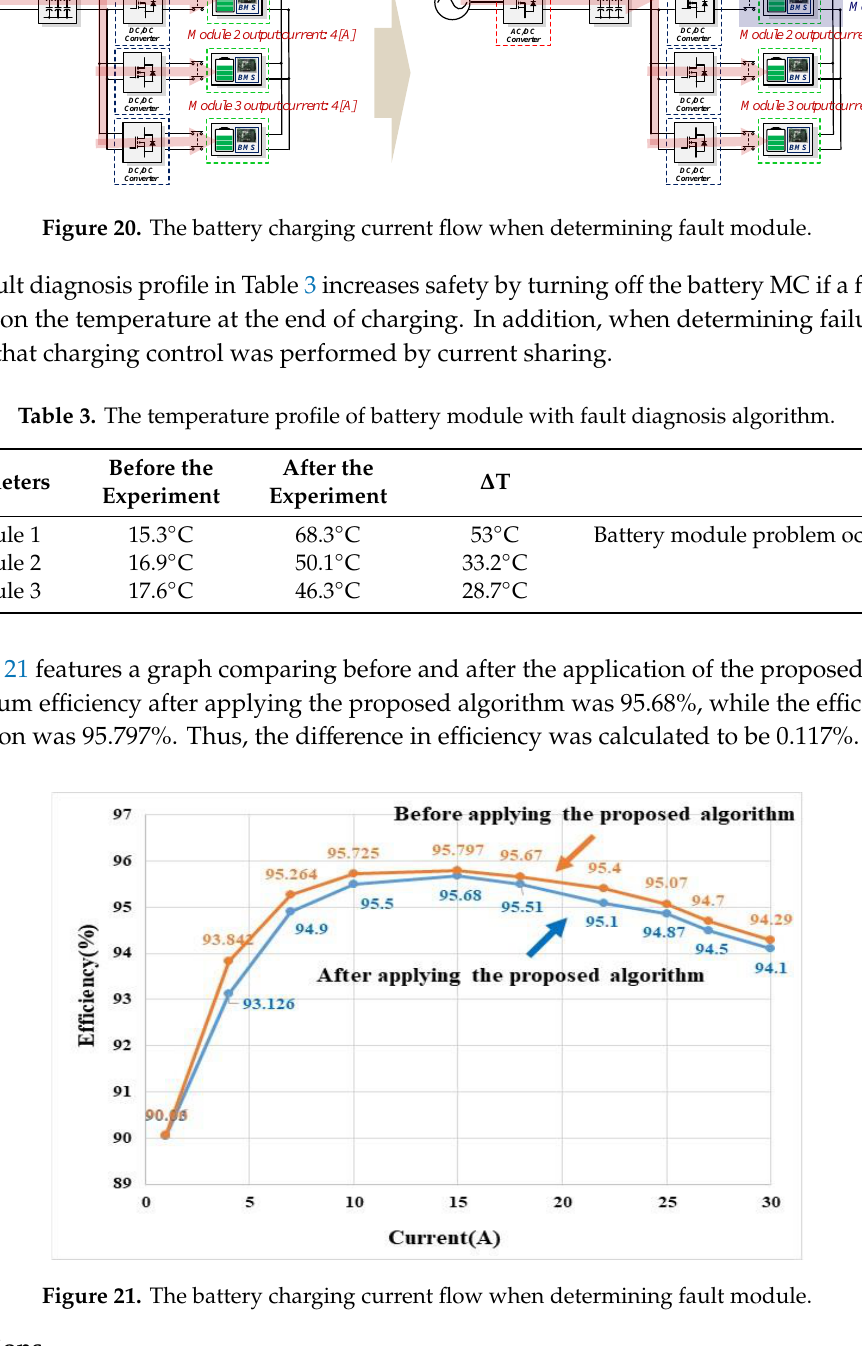
Figure 19. The battery charge current waveform when fault module occurs. ( a ) Sharing of fault module current sharing, ( b ) current waveform at end of charge.